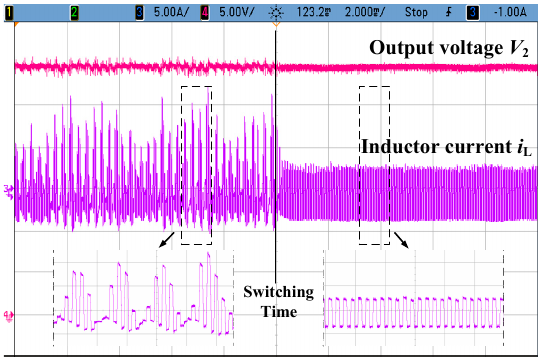
Figure 15. The state variables before and after activating the predictive algorithm.